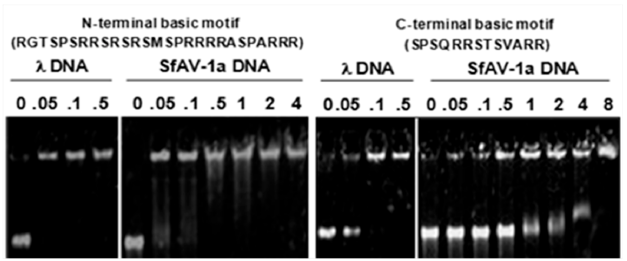
Figure 2. Electrophoretic mobility shift assays showing that synthetic peptides (0.5–8 µg/mL) of basic motifs found in the N-terminal and C-terminal domains of P64 can retard mobility of phage λ and SfAV-1a gDNAs.